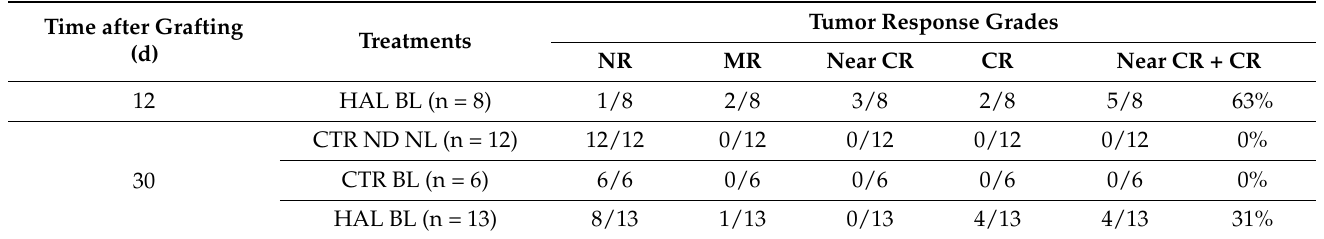
Table 2. HES assessed therapeutic efficacy in rat bladders at 7, 12, and 30 days after tumor inoculation in control and experimental